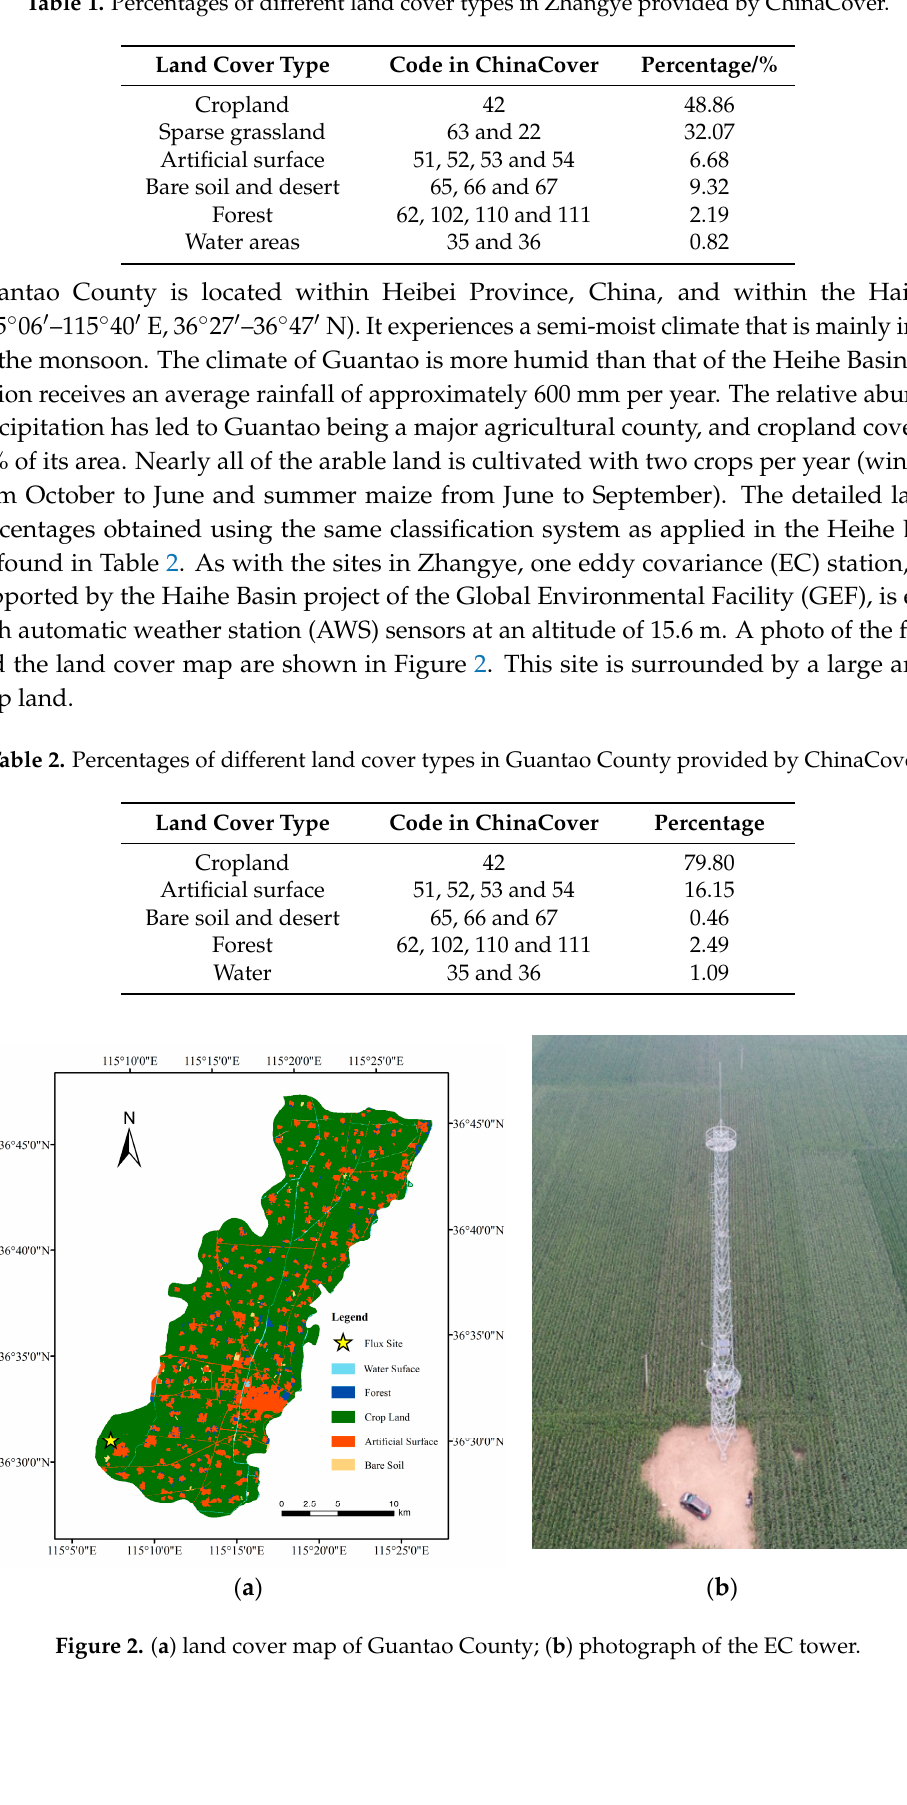
Table 1. Percentages of different land cover types in Zhangye provided by ChinaCover.